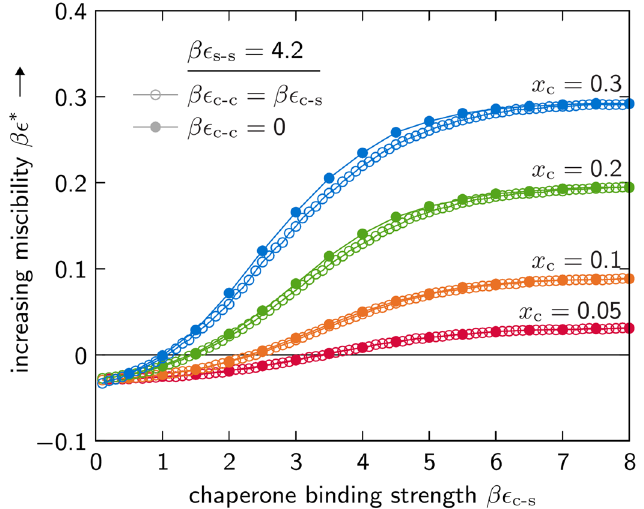
Fig 2. The miscibility limit, β (cid:1) * , of a chaperone – client mixture depends on the chaperone – client binding strength, β (cid:1) c-s , and the chaperone stoichiometric fraction, x c . The chaperone – chaperone interactions have only a minor effect on β (cid:1) * : the miscibility limits of solutions with promiscuous